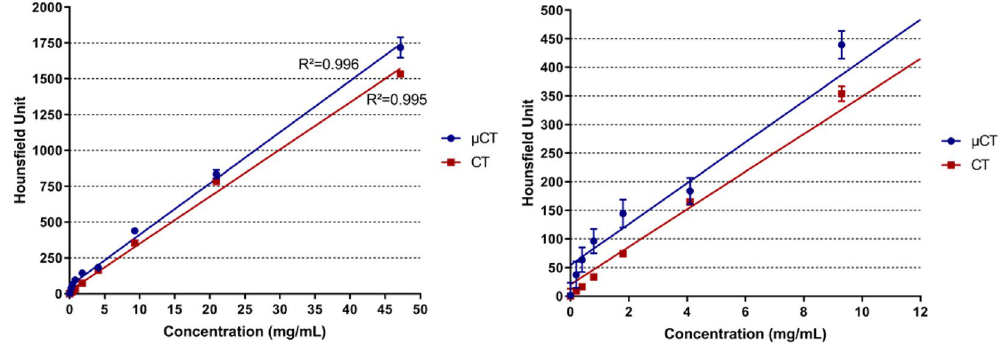
Figure 2. Calibration of GdF 3 , radio opacity measurements (HU) as a function of Gadolinium concentration. The right plot represents a zoom section of the 0–12 mg/mL range issued from the left